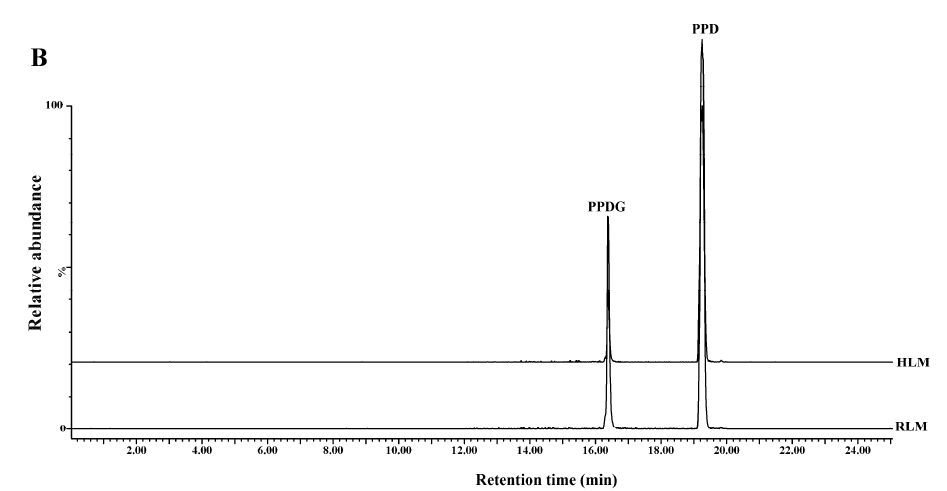
Figure 1. Chemical structures of 20( S )-protopanaxadiol (PPD) and its glucuronidation metabolite catalyzed by human UDP-Glucuronosyltransferase (UGT) 1A3 and UGT 1A4 ( A ). The contributions of these isozymes in this pathway were identified by recombinant UGT isozymes. Representative combined ultra-performance liquid chromatography quadrupole time-of-flight tandem mass spectrometry (UPLC-Q/TOF-MS) chromatograms of PPD and its glucuronidation metabolite; 0.5 mg/mL human liver microsomes (HLMs) or rat liver microsomes (RLMs) was incubated with PPD (100 μ M) at 37 °C for 1 h in the presence of Uridine 5 ′ -diphosphoglucuronic acid trisodium salt (UDPGA) ( B ).